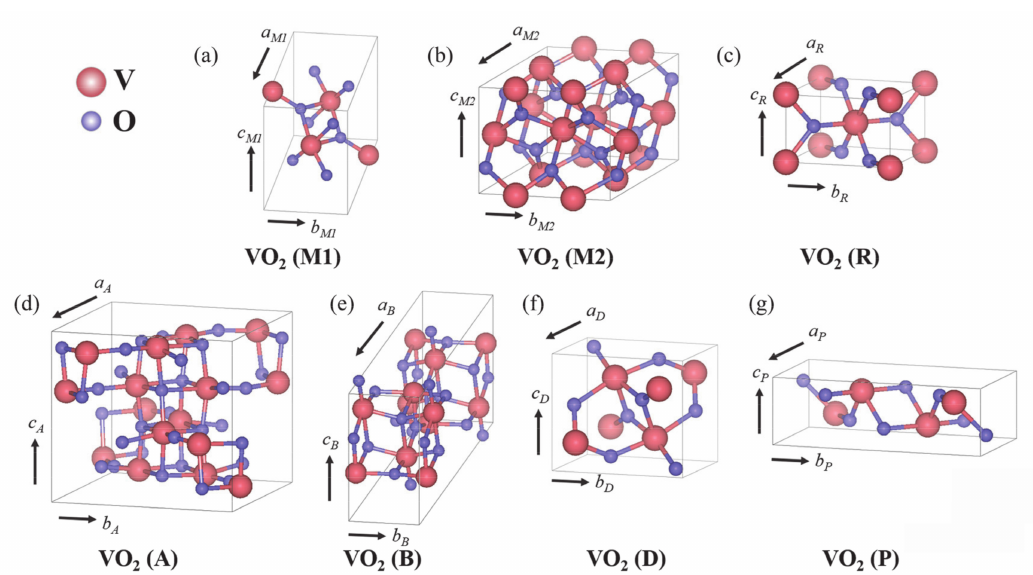
Figure 1. The crystal structures of VO 2 polymorphs, ( a ) VO 2 (M1), ( b ) VO 2 (M2), ( c ) VO 2 (R), ( d ) VO 2 (A), ( e ) VO 2 (B), ( f ) VO 2 (P) and ( g ) VO 2 (D). The corresponding ICSD collection codes of crystal structures are 34033 [VO 2 (M1)], 34417 [VO 2 (M2)], 4110 [VO 2 (R)], 57155 [VO 2 (A)], 73855 [VO 2 (B)] and 22303 [VO 2 (P)], and the crystal structure of VO 2 (D) is modified from [25], with permission from Royal Society of Chemistry,